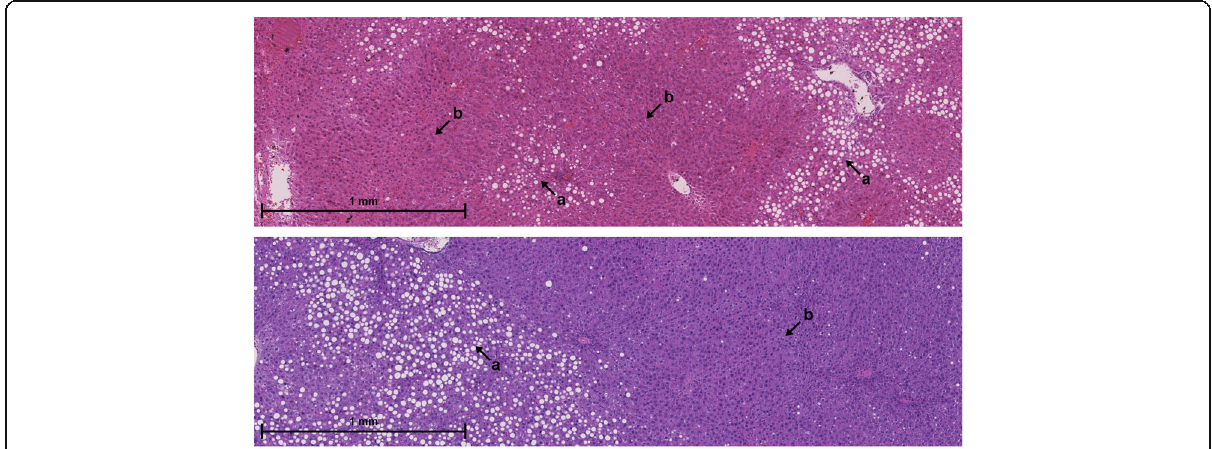
Fig. 2 Spatial heterogeneity of steatosis. Steatotic areas ( a ) and non-steatotic areas ( b ) are distributed heterogeneously across the